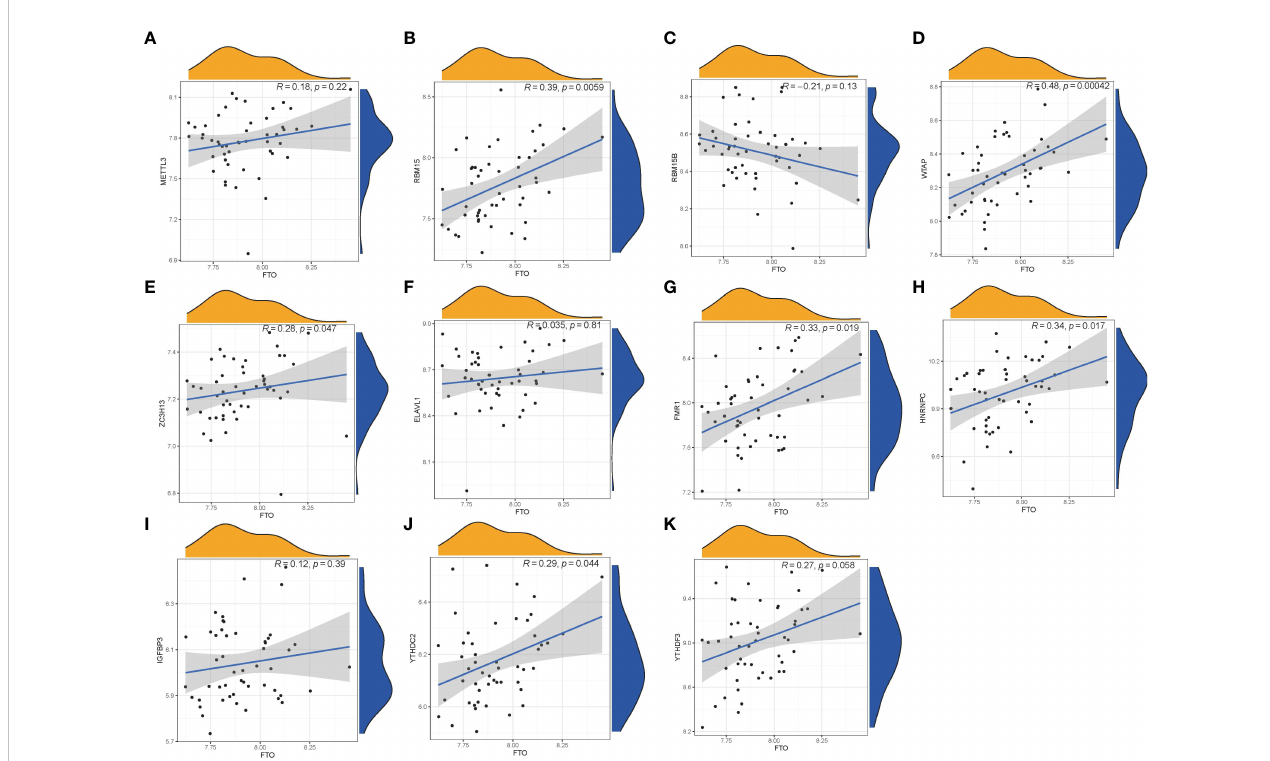
FIGURE 3 Correlation among Writers, Readers and Eraser in PMOP (A – K) . Writer genes: RBM15, RBM15B, METTL3, WTAP, and ZC3H13; reader genes: ELAVL1, FMR1, HNRNPC, IGFBP3, YTHDC2, and YTHDF3; eraser gene: